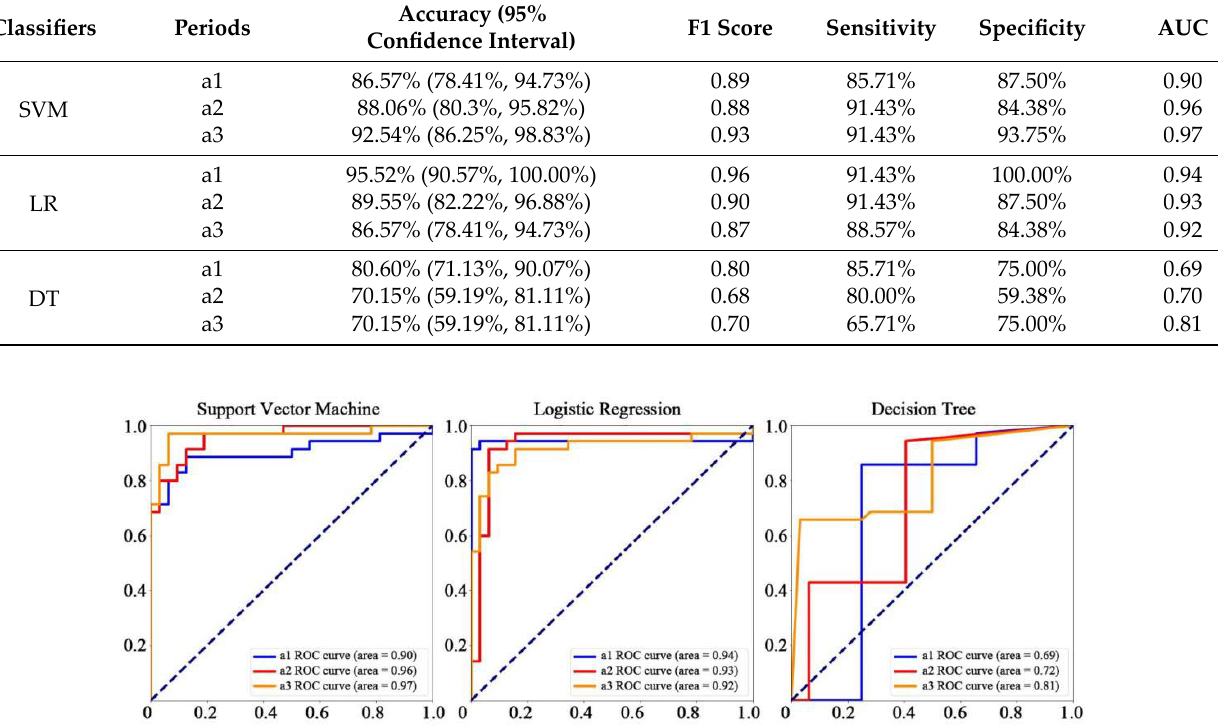
Figure 7. ROC curves of the three classifiers—SVM, LR, and DT—based on the ERP (i.e., SP) and ERSP (i.e., delta, slow alpha, fast alpha, and beta frequency bands) datasets at the CPz electrode across a1, a2, and a3 periods, respectively.